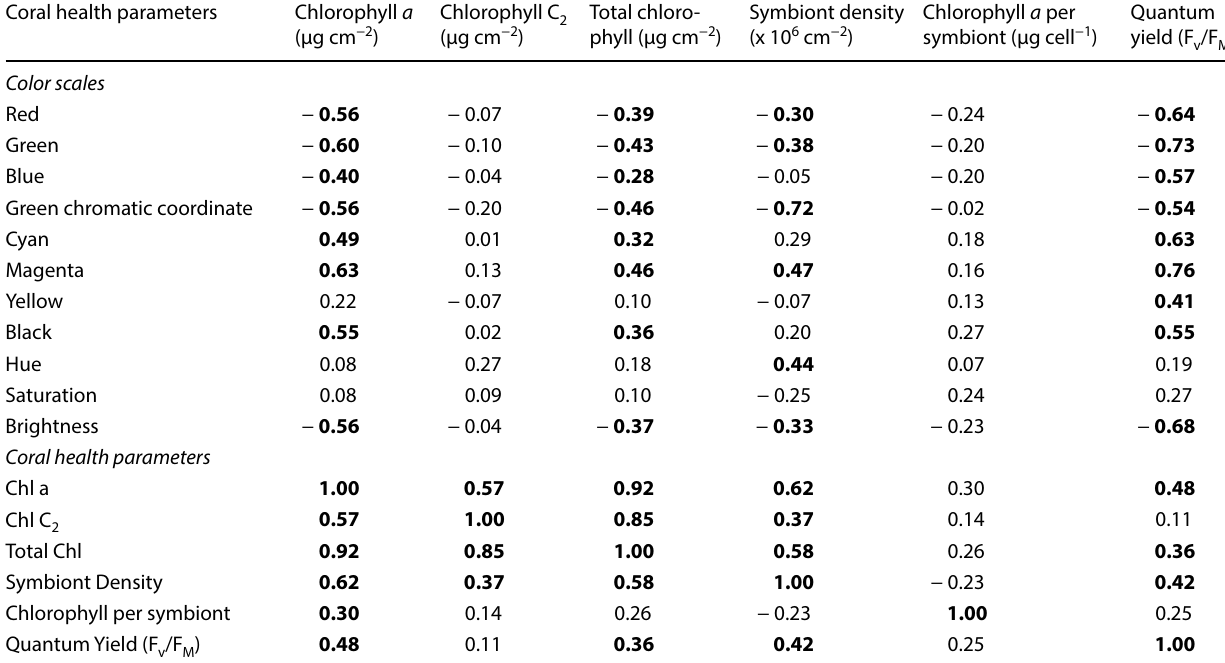
Table 2 Correlation coefficients among coral health parameters (chlorophyll, symbiont density, and photosynthetic efficiency) and color scales (RGB, CMYK, and HSB)